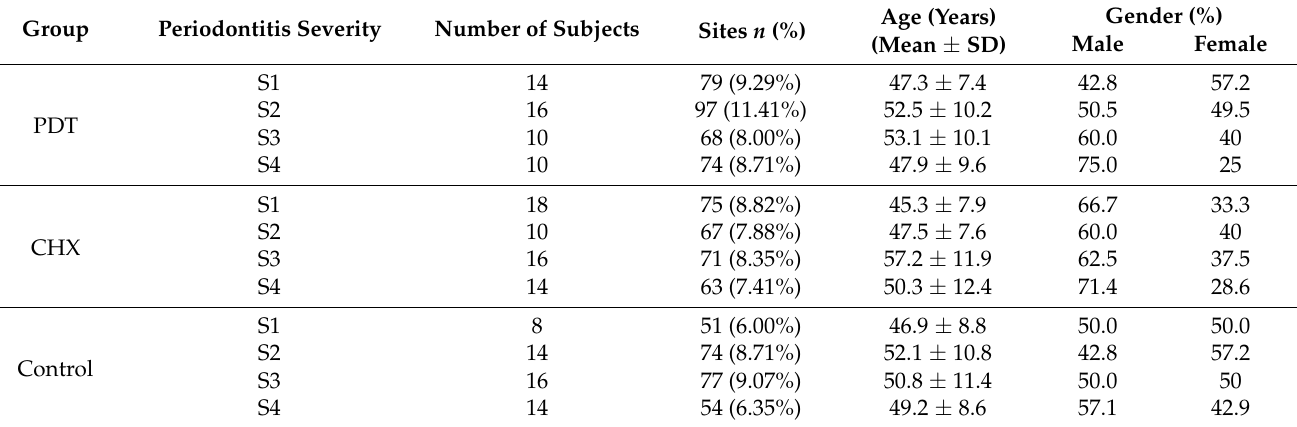
Table 2. General characteristics of study